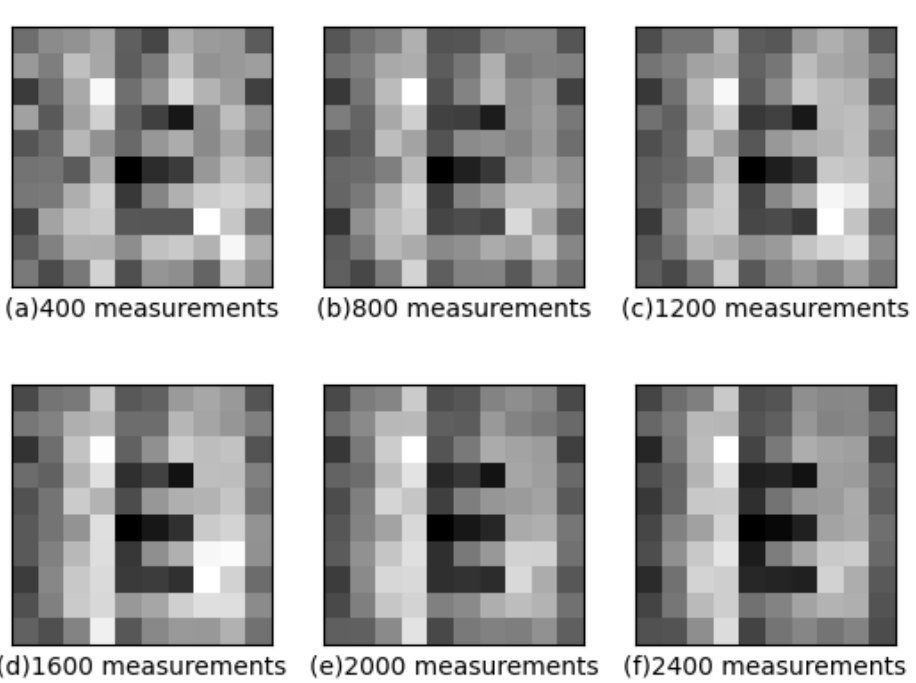
Figure 4. The results of 1.2% concentration solution by DPGI methods in different